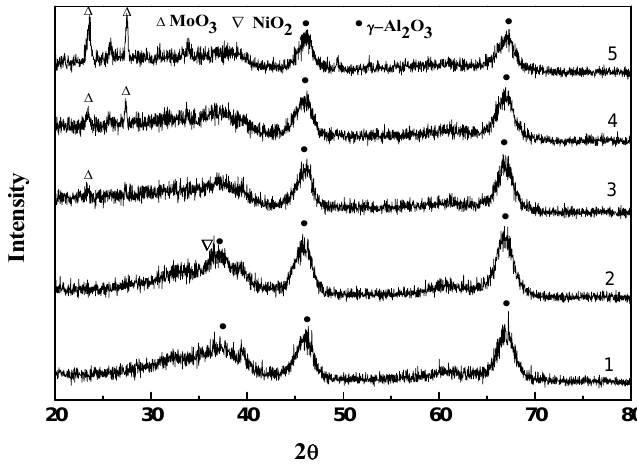
Figure 2. The XRD pattern of the catalyst: ( 1 ) γ -Al 2 O 3 , ( 2 ) NiO-8 wt. %/ γ -Al 2 O 3 , ( 3 ) NiO-5.4 wt. %/ γ -Al 2 O 3 (MoO 3 -2.6 wt. %), ( 4 ) NiO-2.6 wt. %/ γ -Al 2 O 3 (MoO 3 -5.4 wt. %), ( 5 ) MoO 3 -8 wt. % / γ -Al 2 O 3 .